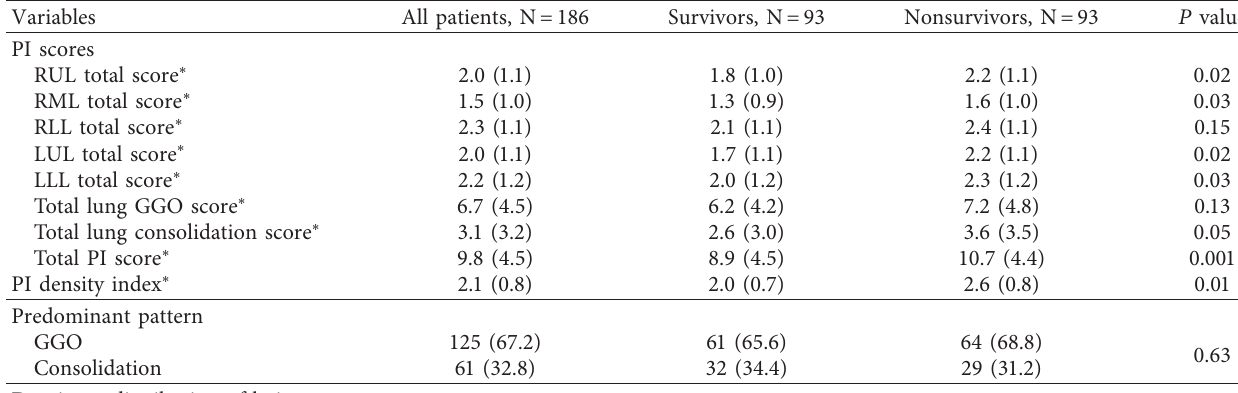
Table 2: Radiologic findings in all patients and differences between the two